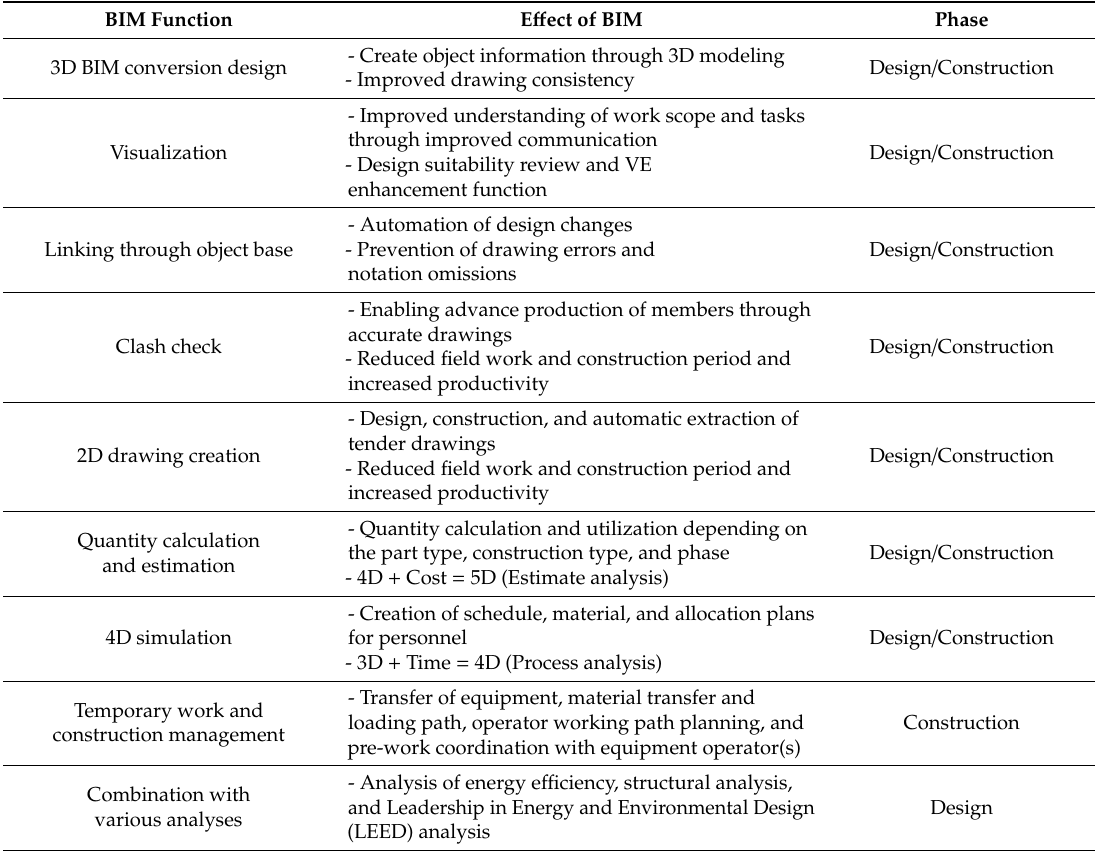
Table 1. Functions and e ff ects of building information modeling